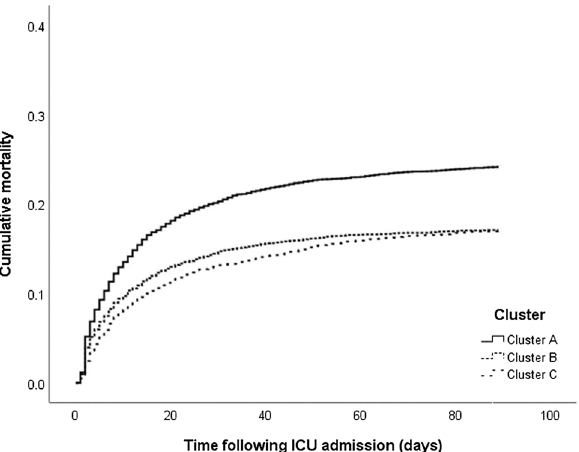
Figure 4. Probability of cumulative mortality according to the three clusters in patients with sepsis (Log-rank p <